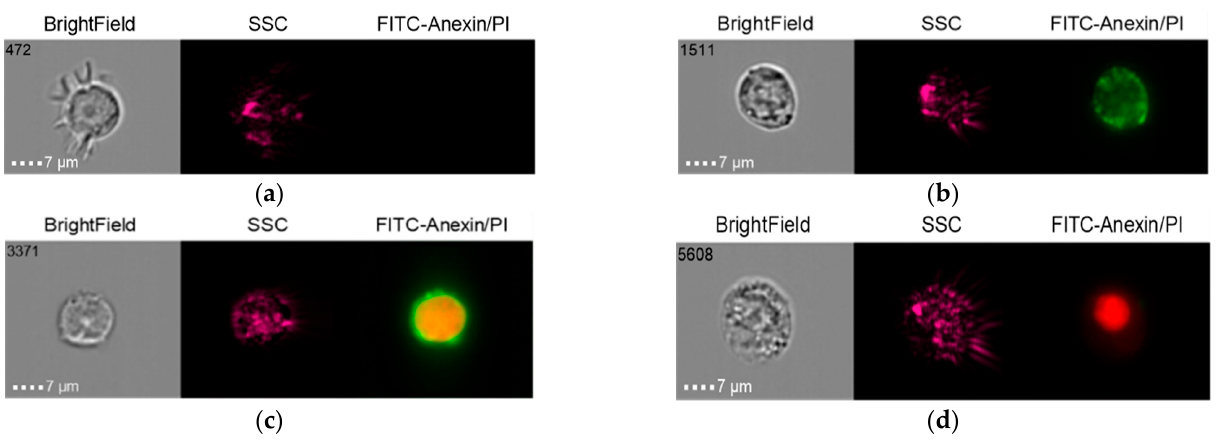
Figure 9. Live cells ( a ), early apoptosis ( b ), late apoptosis ( c ), necrosis ( d ) after co-culture of Nobel Replace NSMP with THP-1 cell line (Nobel Replace NSMP +THP-1).